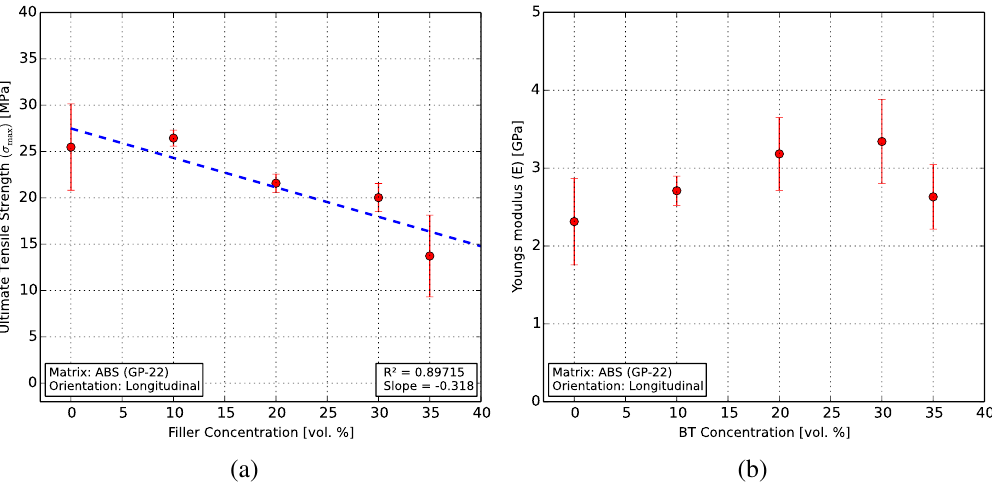
Figure 11. Results from the tensile characterization. ( a ) A linearly decreasing UTS ( σ max ) with increasing BT filler concentration was observed from 25.5 to 13.7 MPa. ( b ) The Young’s modulus of the composites showed a slight increase compared to that of ABS.